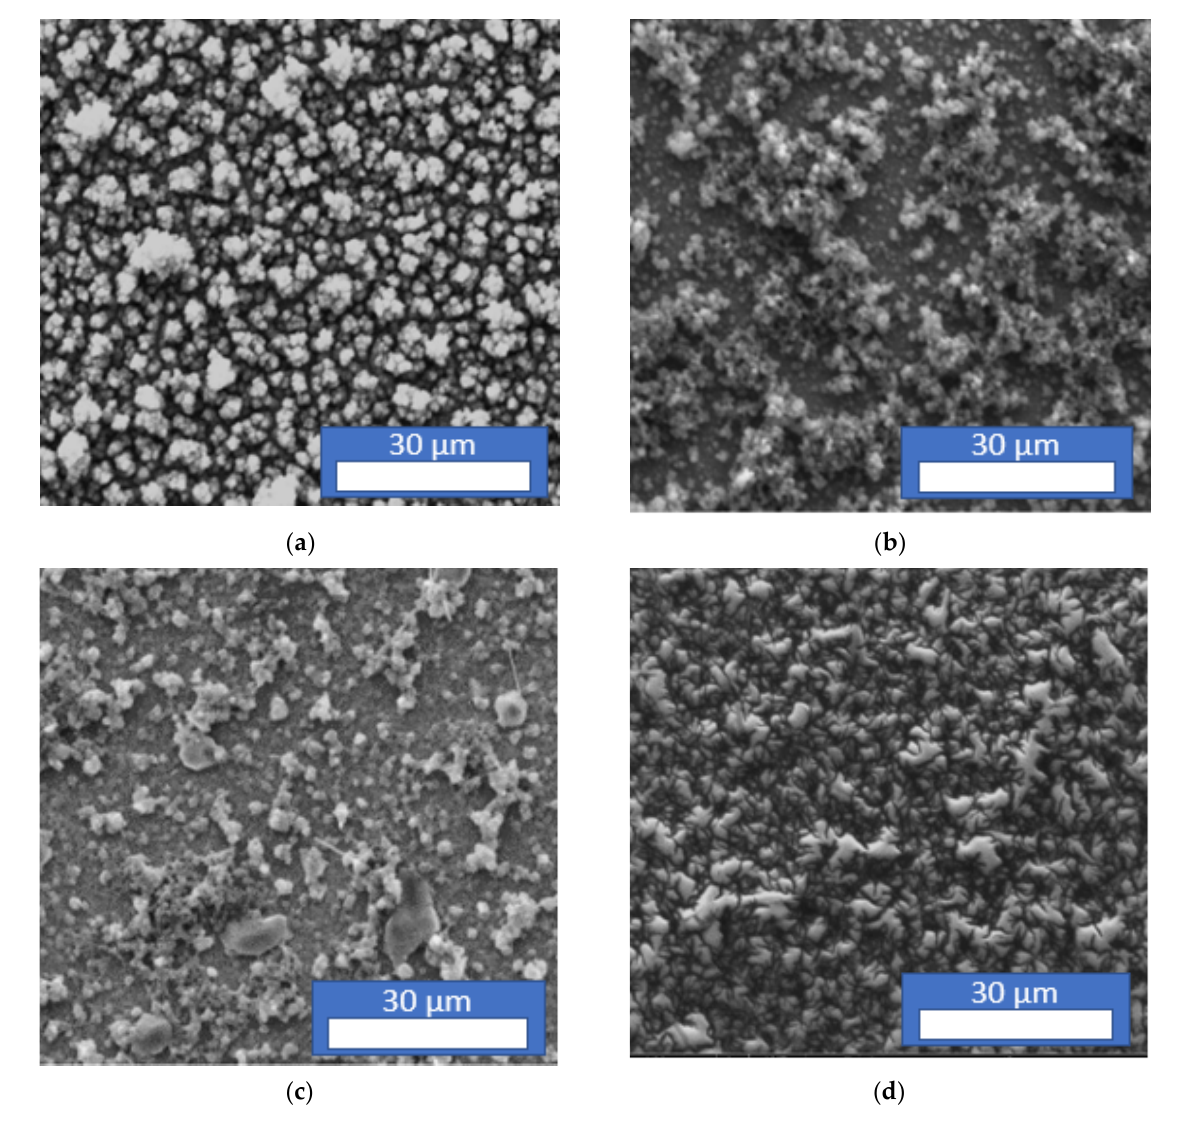
Figure 5. Cyclic voltammograms obtained by oxidation of: 95:5 Cz:CzA ( a ) or 90:10 Cz:CzA ( b ) in an acetonitrile + 0.1 M LiClO 4 solution (WE: Pt. Scan rate: 50 mV/s) and 3D morphology AFM pic- tures of the polymer films resulting from the electro-oxidation of 95:5 Cz:CzA ( c ) and 90:10 Cz:CzA ( d ) solutions.